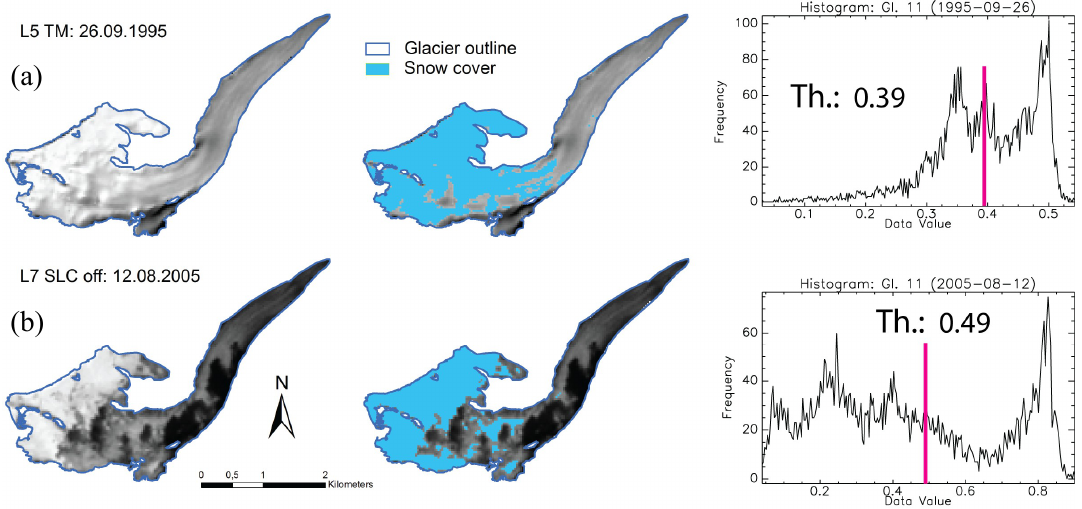
Figure 11. Snow cover mapping performance for two problematic cases. ( a ) HEF with fresh snow cover and its associated wrong mapping. ( b ) HEF with clouds and its related shadows, which also cause the algorithm to fail. Right panels show the respective histograms of the Ekstrand corrected image. A clear selection of a threshold is difficult in these cases.